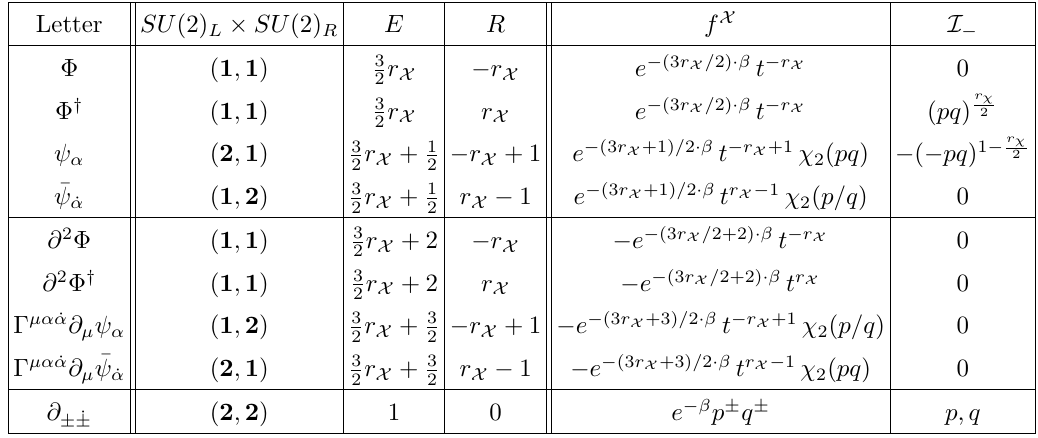
Table 2. Letter partition function of an N = 1 chiral